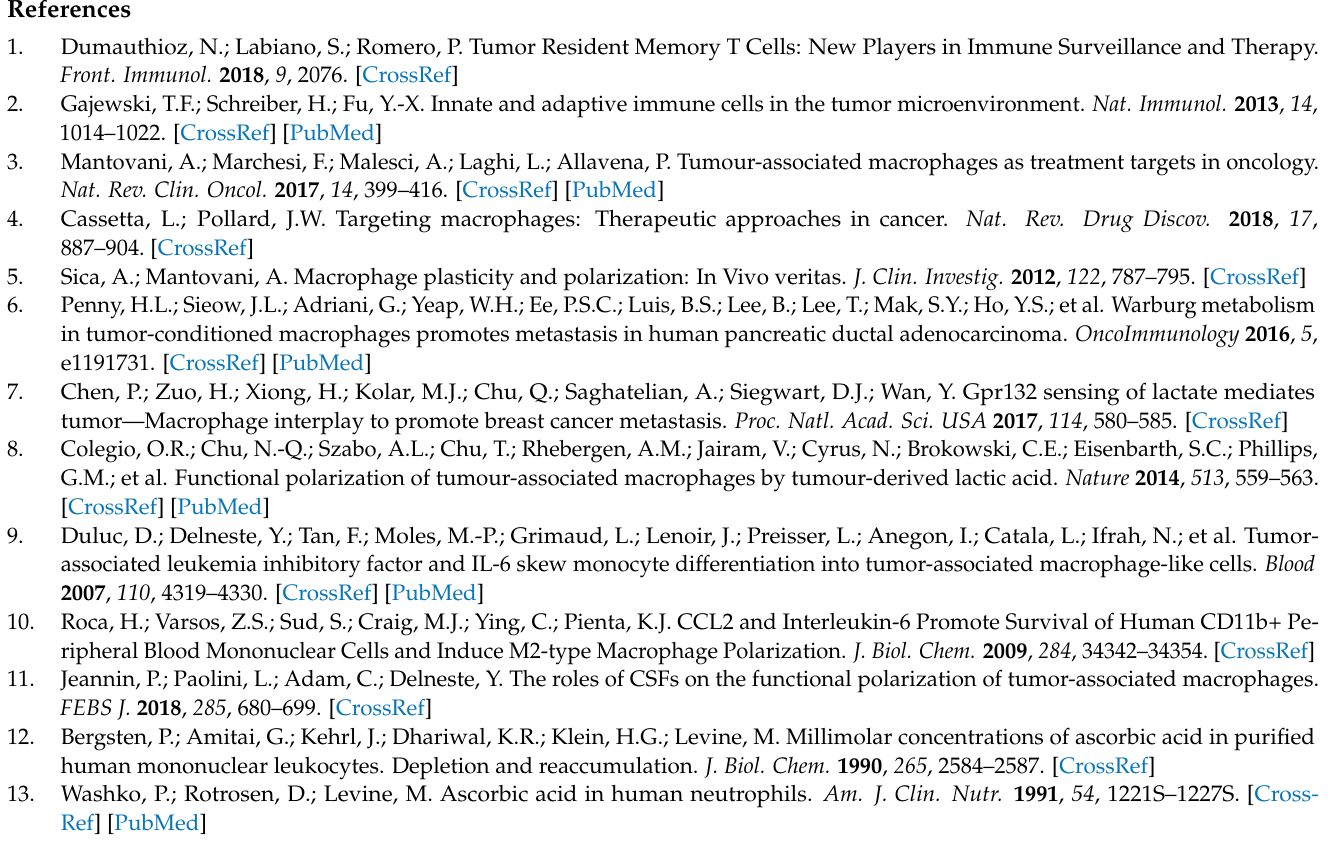
Figure A1. IgG control immunostaining of bone marrow cells. Isolated bone marrow cells were grown, then fixed and probed in situ with corresponding IgG controls for CD11b and F4/80 primary antibodies and subsequent fluorescent secondary antibodies. These IgG control cells were used to determine non-specific fluorescent background threshold.